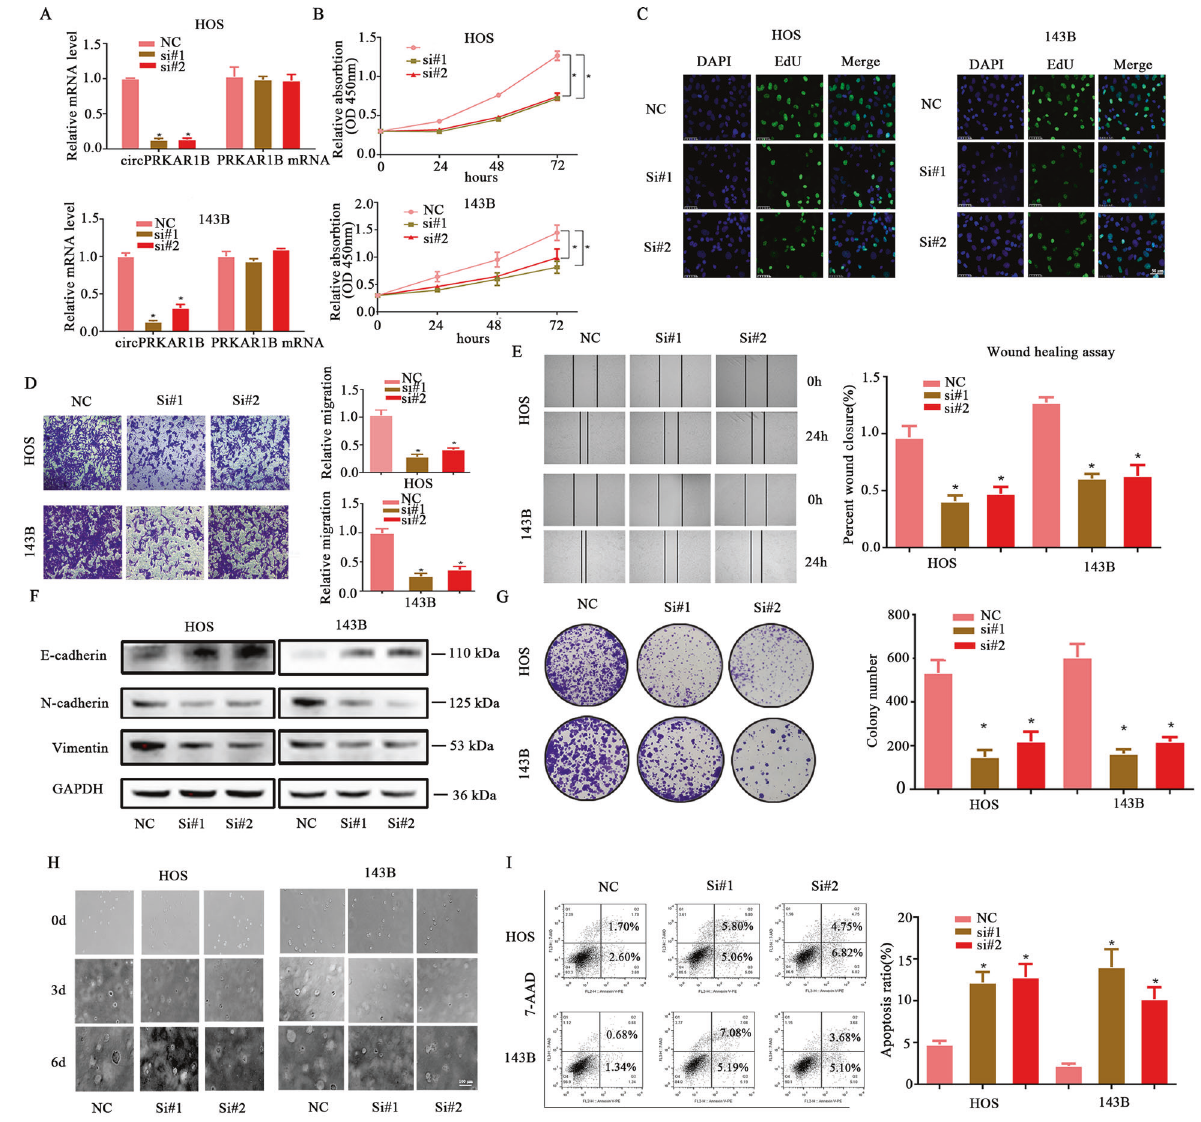
Fig. 2 circPRKAR1B knockdown inhibited the migration and proliferation of OS cells. A HOS and 143B cells were stably transfected with circPRKAR1B siRNA or NC, and the mRNA expression levels of circPRKAR1B and PRKAR1B were measured by RT-qPCR. B The proliferation of HOS and 143B cells transfected with sh-circPRKAR1B was measured by the CCK-8 assay. C CircPRKAR1B plays a role in tumour cell proliferation, as determined by the EdU assay. Nuclei were stained with DAPI, and the combination of EdU and DAPI indicated cells in S phase. D The migration abilities of HOS and 143B cells transfected with si-circPRKAR1B or NC were evaluated by Transwell migration assays. E The effect of si-circPRKAR1B on migration was evaluated by the wound-healing assay in HOS and 143B cells. F The protein expression of N-cadherin, E-cadherin and Vimentin was measured by Western blot analysis in both HOS and 143B cells transfected with si-circPRKAR1B. G SiRNA- mediated circPRKAR1B knockdown signi fi cantly suppressed cell growth in the colony formation assay. H circPRKAR1B knockdown inhibited the anchorage-independent colony-forming abilities of both HOS and 143B cells. I HOS and 143B cells were transfected with si-circPRKAR1B and then subjected to Annexin V-PE/7AAD staining. The percentage of apoptotic cells is shown. The data represent the mean ± SD ( n = 3) (* P < transfected with FZD4 overexpression plasmid (Fig. 5A). To circPRKAR1B facilitates OS progression through the FZD4/ verify whether miR-361-3p inhibits cell migration and EMT in OS Wnt/ β -catenin axis via the FZD4/Wnt/ β -catenin axis, 143B and HOS cells were Given the binding relationship between miR-361-3p and FZD4, cotransfected with miR-361-3p mimics and a FZD4 overexpres- whether miR-361-3p regulated OS process by targeting FZD4 sion (OE) plasmid. It was found that the levels of β -catenin, was continued to be explored. FZD4 has been reported to cyclin D1, C-myc, Vimentin and N-cadherin were signi fi cantly promote Wnt/ β -catenin signalling and markedly affect numer- increased, while E-cadherin expression was reduced in cells ous neoplastic diseases [30, 31], but there are few reports on the cotransfected with miR-361-3p mimics and the FZD4-OE plasmid function of FZD4 in osteosarcoma. Results fi rstly presented FZD4 compared with those transfected with miR-361-3p mimics alone protein expression and Wnt/ β -catenin signalling related proteins (Fig. 5B). The colony-forming ability of OS cells was rescued by were dramatically upregulated in 143B and HOS cells